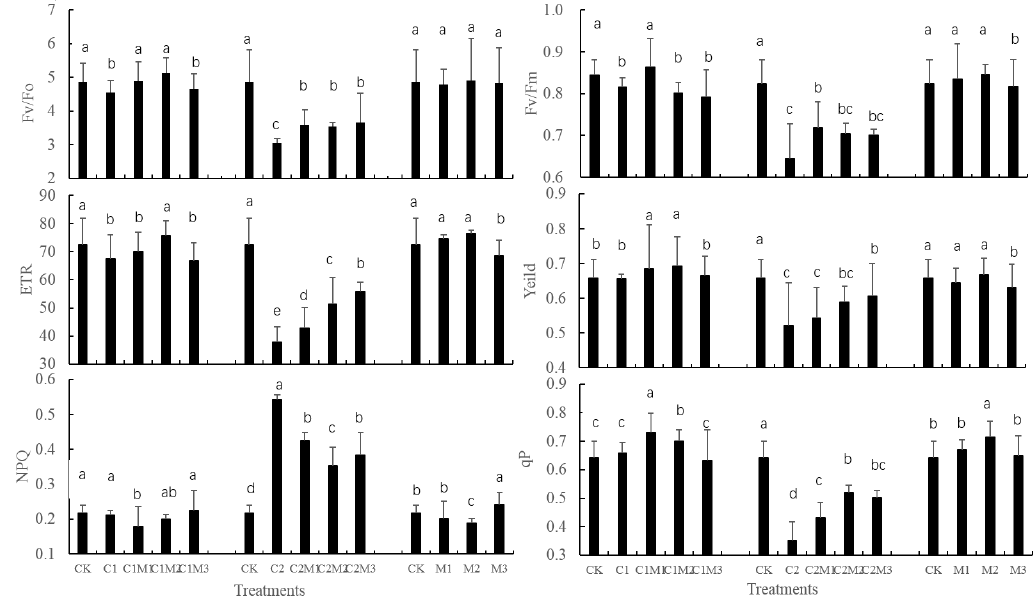
Figure 2. Effect of exogenous Mo on chlorophyll fluorescence parameters in rape plants under different levels of Cd treatments ( n = 4). Note: Data are the mean ± standard deviation. Different lowercase letters above the error bars indicate significant differences ( p < 0.05). CK (control group), C1 (treatment by 0.5 mg/kg Cd), C1M1 (treatment by 0.5 mg/kg Cd and 50mg/kg Mo), C1M2 (treatment by 0.5 mg / kg Cd and 100 mg / kg Mo), C1M3 (treatment by 0.5 mg / kg Cd and 200 mg / kg Mo), C2 (treatment by 6.0 mg / kg Cd), C2M1 (treatment by 6.0 mg / kg Cd and 50 mg / kg Mo), C2M2 (treatment by 6.0 mg / kg